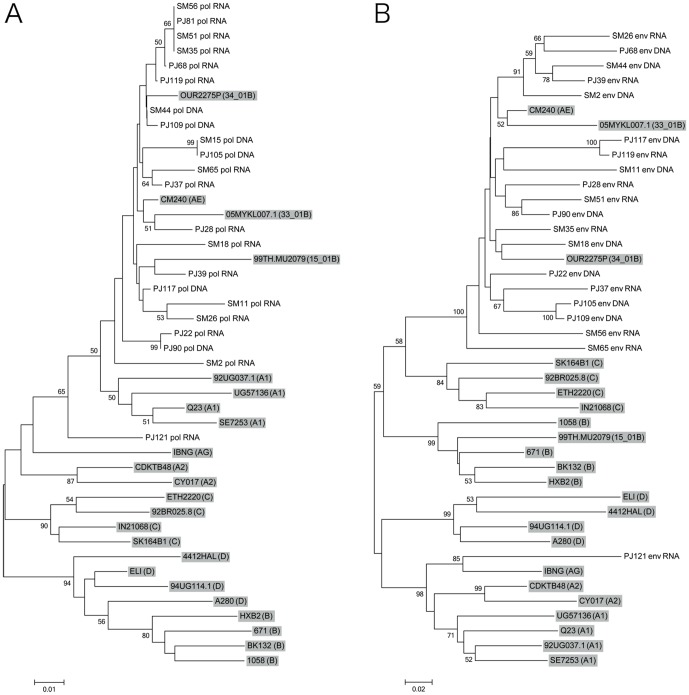
Phylogenetic relationship of HIV-1 pol and env gene sequences.Phylogenetic trees were generated for newly sequenced HIV-1 pol (A) and env (B) genes together with the corresponding viral gene of reference HIV-1 strains representing subtype A1 (A1), subtype A2 (A2), subtype B (B), subtype C (C), subtype D (D), CRF01_AE (AE), CRF02_AG (AG), CRF15_01B (15_01B), CRF33_01B (33_01B) and CRF34_01B (34_01B) (shown with a gray background). Bootstrap values are shown when the values are >50. Scale bar represents 0.01 (A) or 0.02 nucleotide substitutions per site (B). The nucleotide sequences of pol and env genes determined in this study have been deposited in the GenBank database under accession numbers KF147334-KF147375.